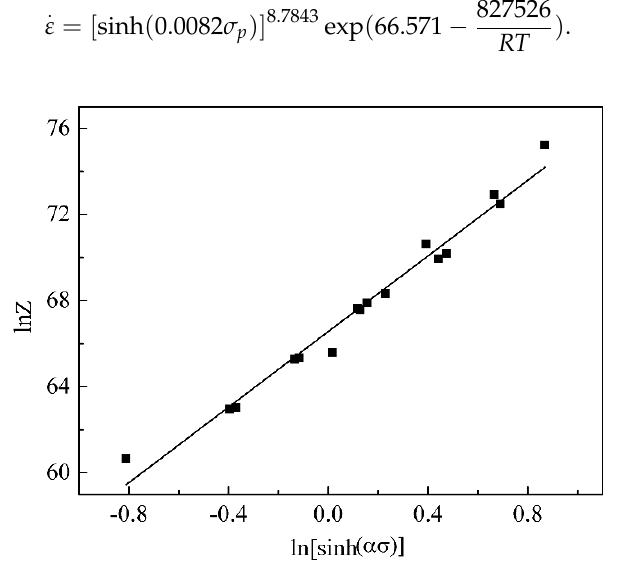
Figure 4. Relationship between the Zener–Hollomon parameter and the flow stress of the ODS